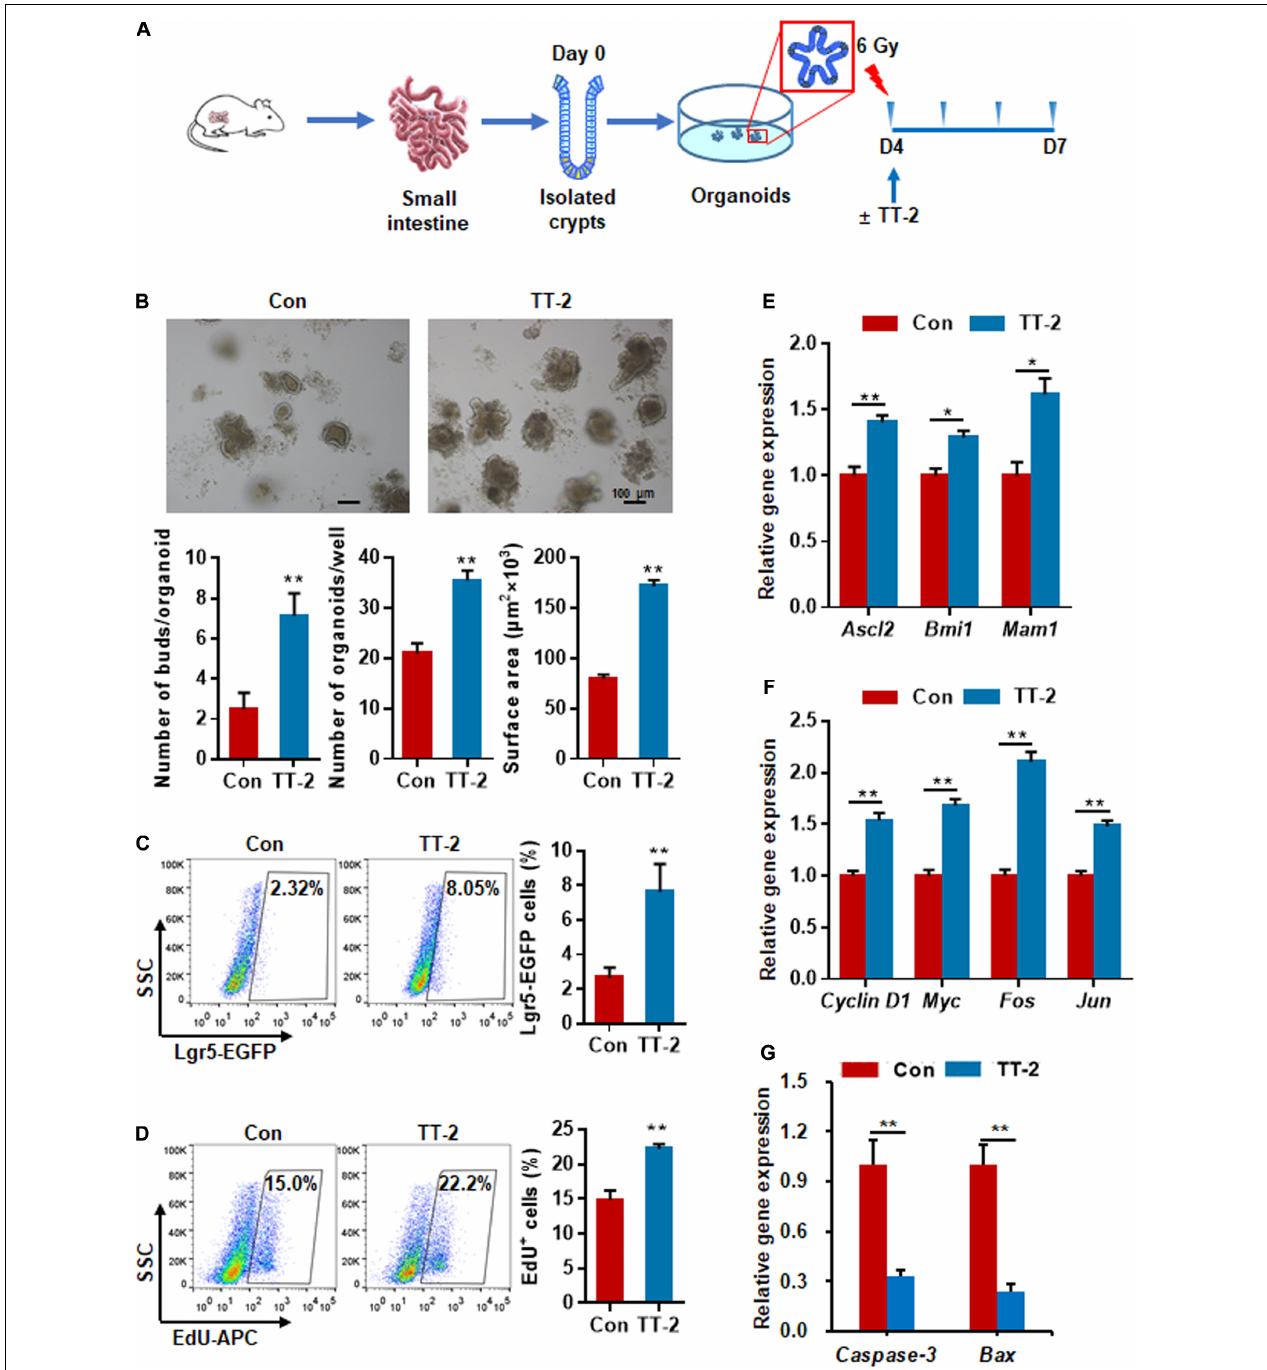
FIGURE 3 | Active fraction of Trillium tschonoskii (TT) promoted intestinal organoid growth after irradiation. (A) Schematic diagram of organoid isolation and irradiation. (B) Representative phase contrast microscopic images of intestinal organoids cultured in presence of TT-2, and quantification of organoid numbers per well, bud numbers, and surface area of each organoid (** p < 0.01, scale bar = 100 µ m). (C) Representative dot plots and percentages of EGFP + cells in the intestinal organoids with or without TT-2. The intestinal crypts were isolated from Lgr5-EGFP-IRES-creERT2 mice (** p < 0.01). (D) The percentage analysis of EdU incorporation for 4 h in organoids after 6 Gy irradiation with or without the addition of TT-2 to the medium for 48 h (** p < 0.01). (E) qPCR for ISC-related gene expression in organoids after 6 Gy irradiation with or without TT-2 treatment for 48 h (* p < 0.05, ** p < 0.01). (F) qPCR for proliferation-related gene expression in organoids after 6 Gy irradiation with or without TT-2 treatment for 48 h (** p < 0.01). (G) qPCR for apoptosis-related gene expression in organoids after 6 Gy irradiation with or without TT-2 treatment for 48 h (** p < 0.01).